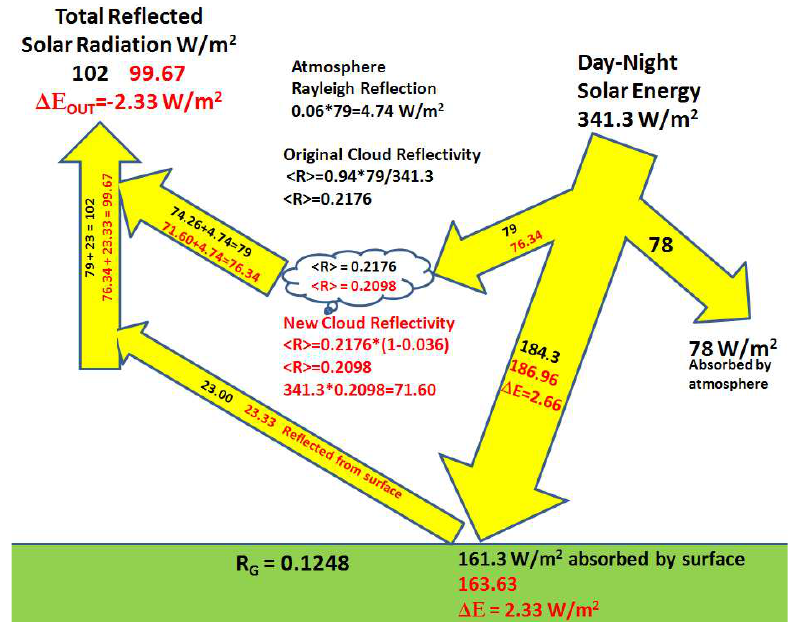
Figure 10 Shortwave energy balance diagram based on Trenberth et al. (2009). The numbers in black are from Trenberth. The numbers in red are from the effect of perturbing the cloud + aerosol reflectivity <R> by 3.6% from Trenberth’s implied value of 21.76 RU to 20.98 RU. The result is an increase of 1.4% in energy absorbed by the surface. All other parameters are held constant. is 341.3 − 78–79 = 184.3 W m − 2 , of which 23 W m − 2 is